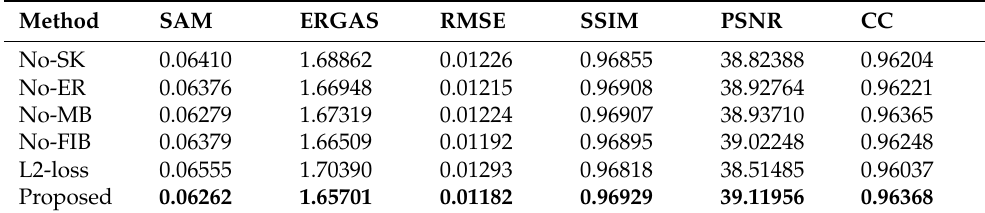
Table 4. Comparative metrics of the impact of different blocks on the model on the LGC dataset.